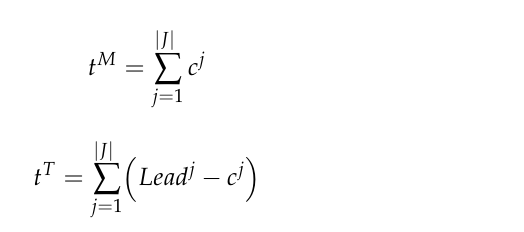
Figure 7. The mean plots and Tukey HSD intervals (α = 0.05) for |𝐽| , |𝑇| , |𝐶| , and 𝛿 groups. ( a ) |𝐽| group. ( b ) |𝑇| group. ( c ) |𝐶| group. ( d ) 𝛿 group.